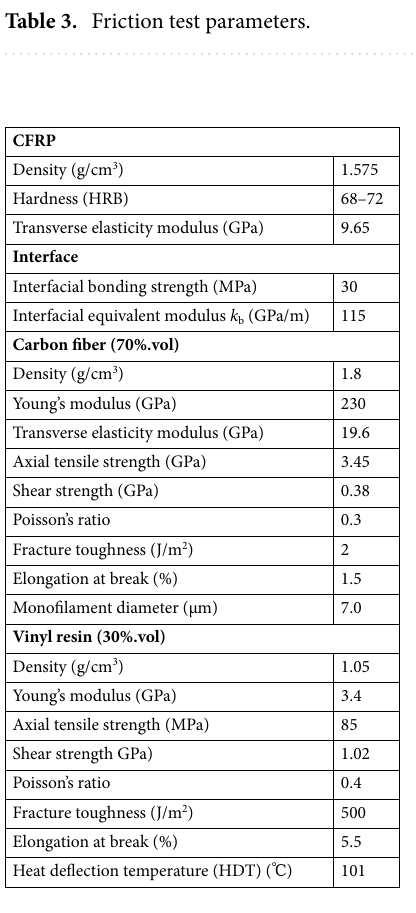
Table 4. Specimen material properties.